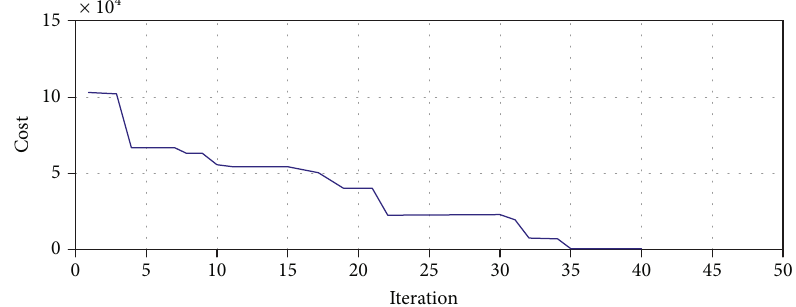
Figure 14: Genetic algorithm for best fi tness target point in two-segment catheter.